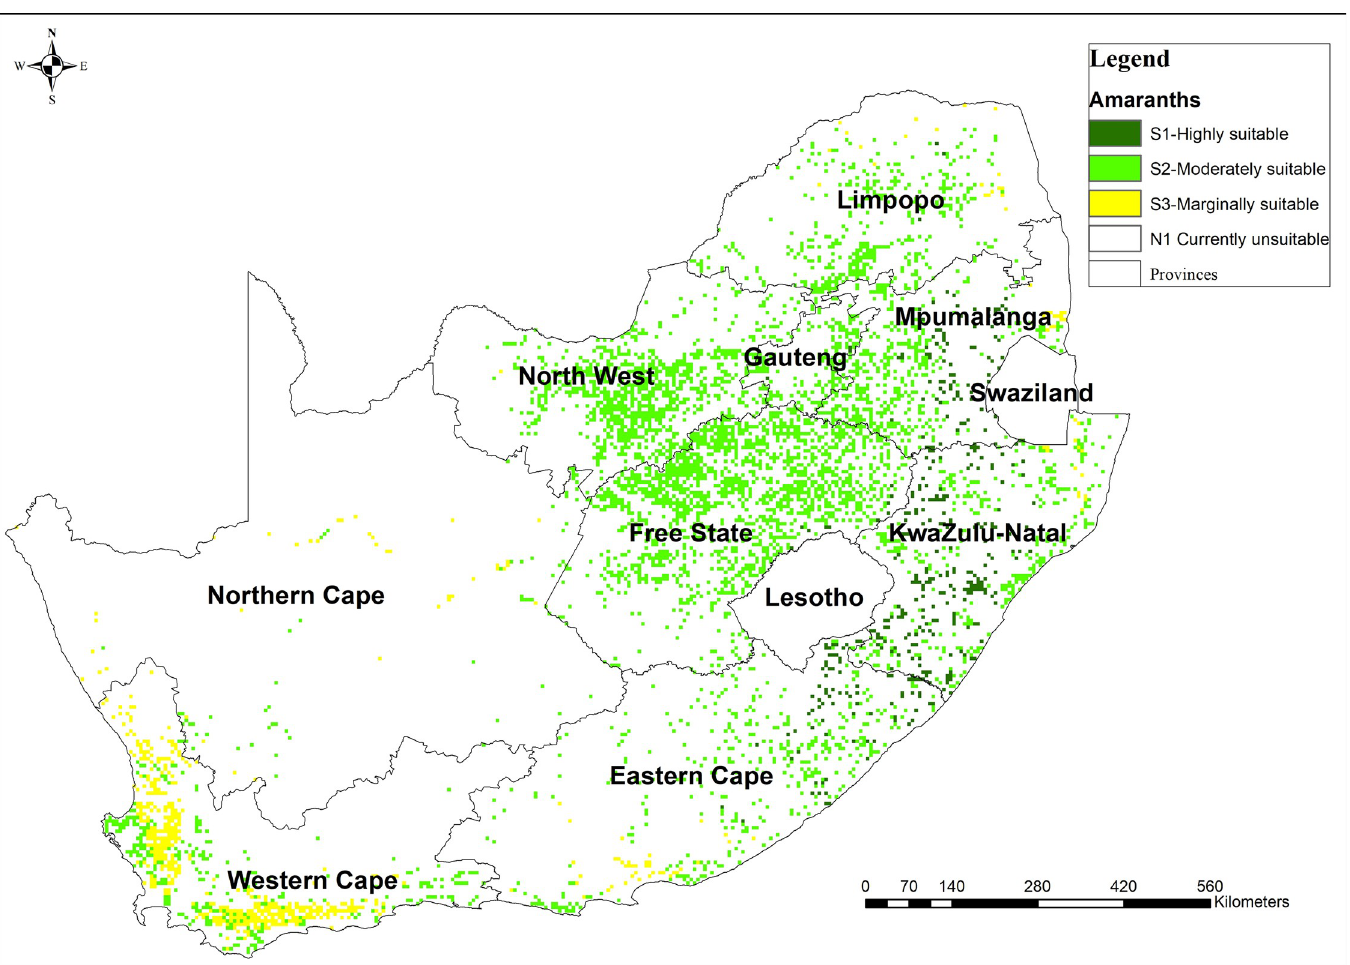
Fig 5. Suitability map for amaranth production in South Africa computed using MCDA-AHP and OWA operators. [Source, South African Quaternary Catchments database , ( https://doi.org/10.6084/m9.figshare.13179881 ) , in ArcGIS 10 . 5]